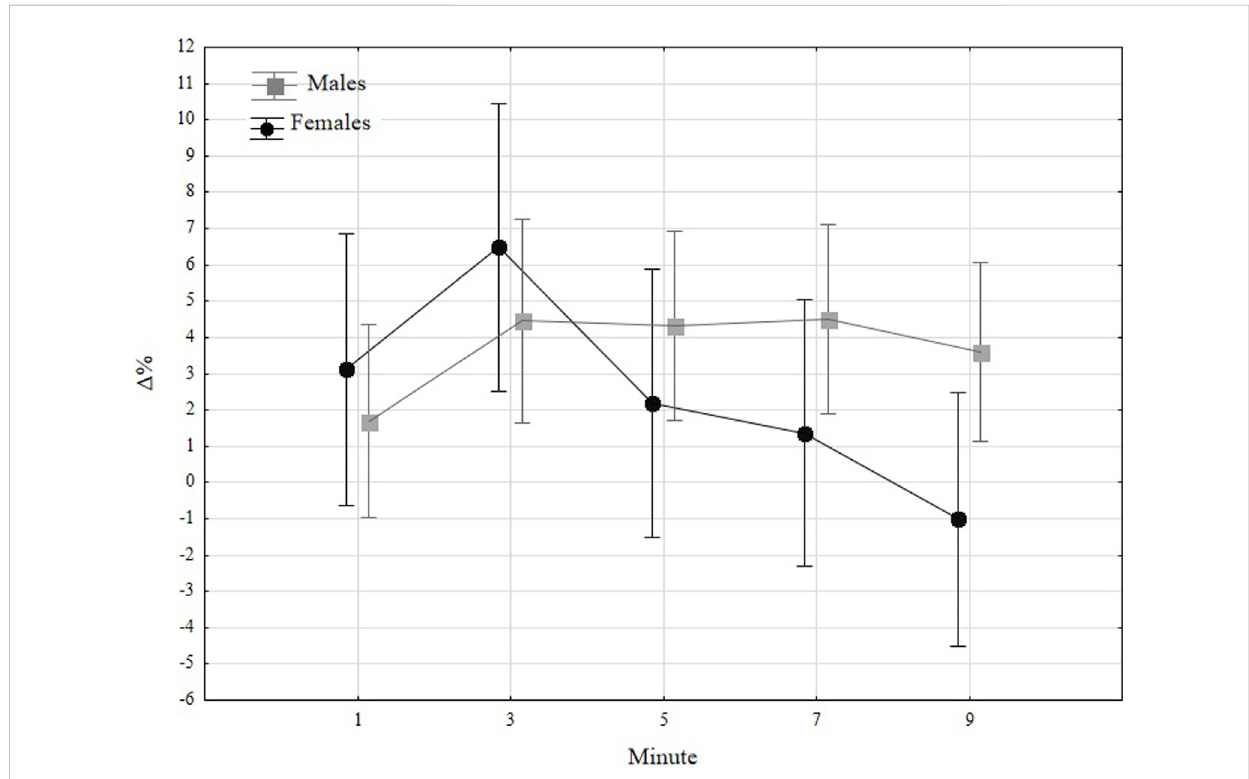
FIGURE 3 Relative changes ( Δ %) towards baseline in jump height in males and